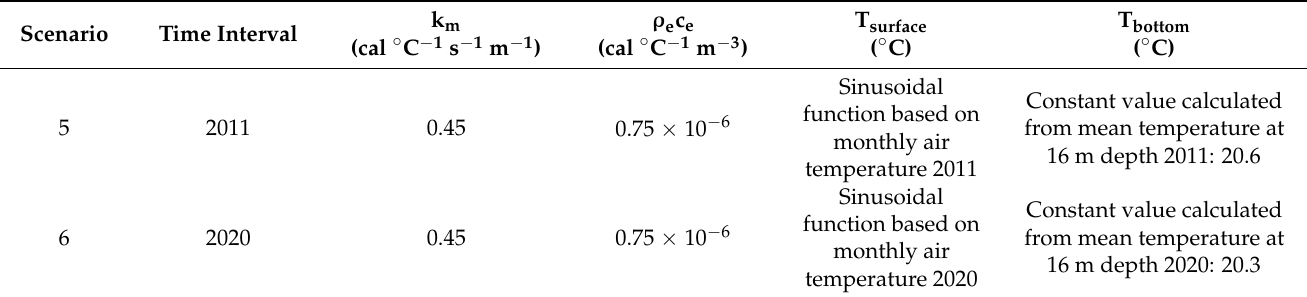
Table 2. Boundary conditions and parameters defined in scenarios 5–6 of P-II.